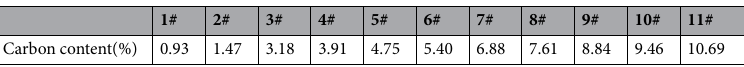
Table 3. Carbon content of fly ashes.